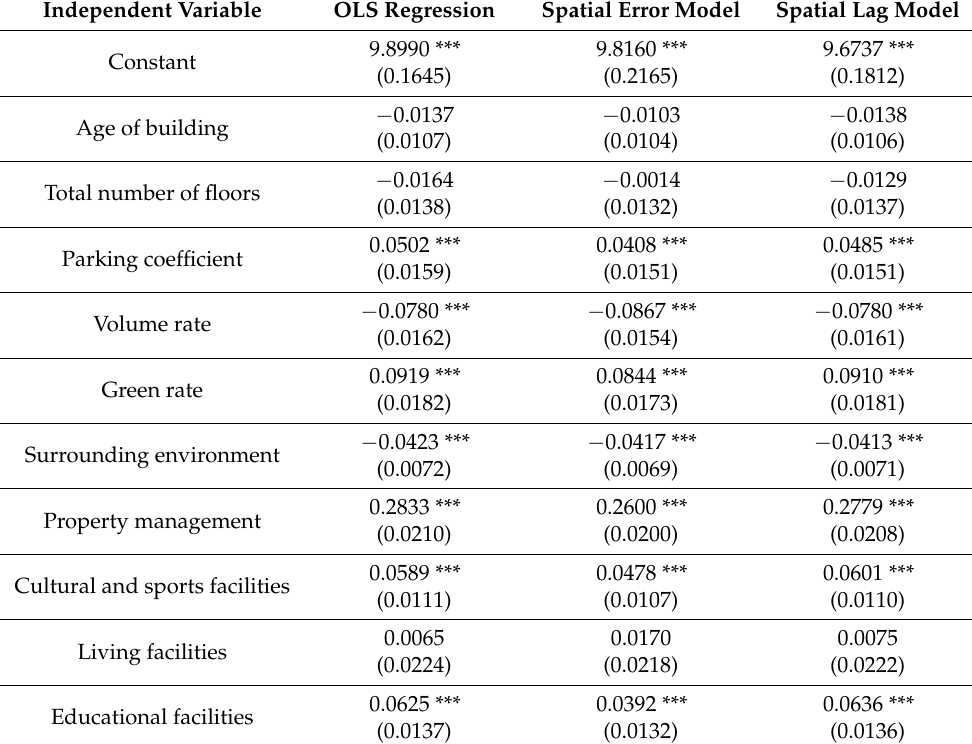
Table 5. OLS regression, Spatial Error Model and Spatial Lag Model results for housing selling prices ( n =